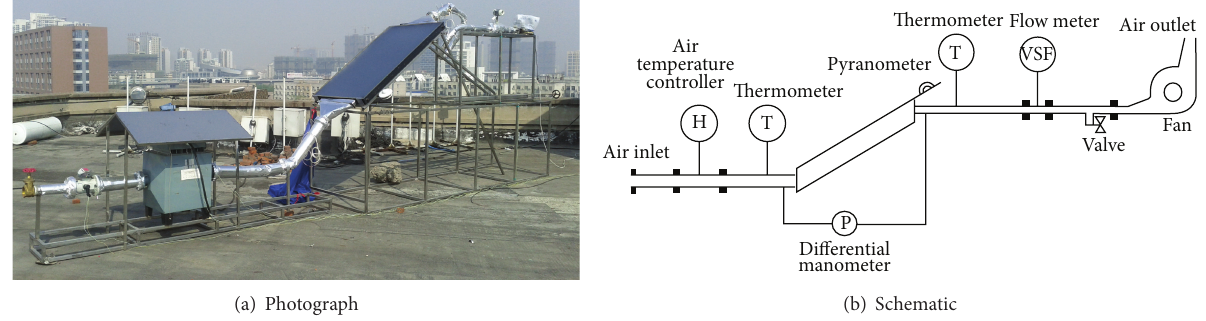
Figure 3: Configuration of the experimental setup of air heating test system.